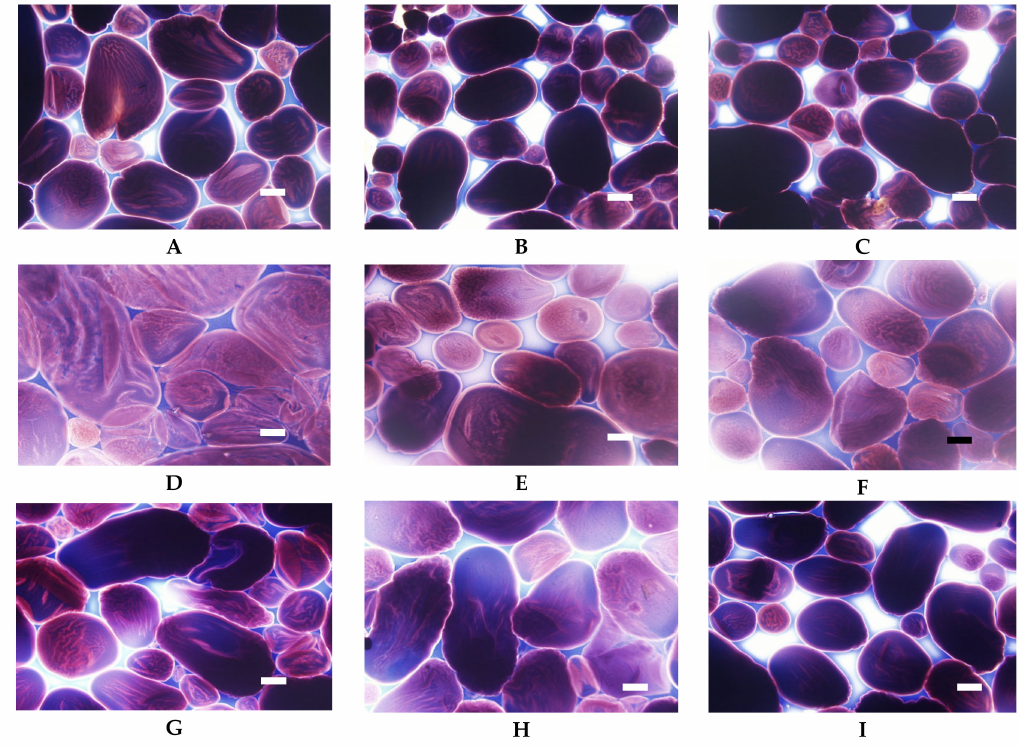
Figure 11. LM micrographs (20 × ) of acetylated distarch phosphates of potato origin with di ff erent degrees of crosslinking (L–low, M–medium, H-high) incubated in di ff erent conditions: ( A ) L, 90 ◦ C, pH = 5.5; ( B ) M, 90 ◦ C, pH = 5.5, ( C ) H, 90 ◦ C pH = 5.5; ( D ) L, 123 ◦ C, pH = 5.5; ( E ) M, 123 ◦ C, pH = 5.5, ( F ) H, 123 ◦ C, pH = 5.5; ( G ) L, 90 ◦ C, pH = 3.5; ( H ) M, 90 ◦ C, pH = 3.5, ( I ) H, 90 ◦ C pH = 3.5 (Bar-20 µ